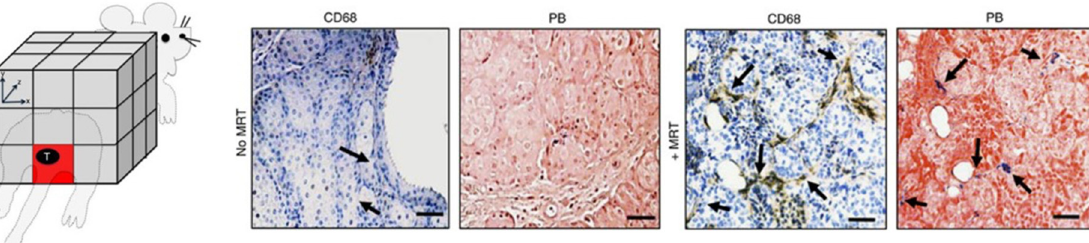
Figure 8. Magnetic Resonance Targeting technique. Magnetic resonance targeting (MRT) to vectorize circulating macrophages to prostate tumors and lung metastasis. Schematic of targeted regions using imaging gradients for MRT, where a– y gradient was equally applied across the animal to target the location of the prostate as depicted (red box). Histological staining of paraffin wax-embedded tumor sections with an anti-human CD68 antibody and Prussian blue (CD68-positive macrophages are brown and SPIO-positive macrophages are blue: see arrows). Adapted and Reproduced with permission from Ref. [295].